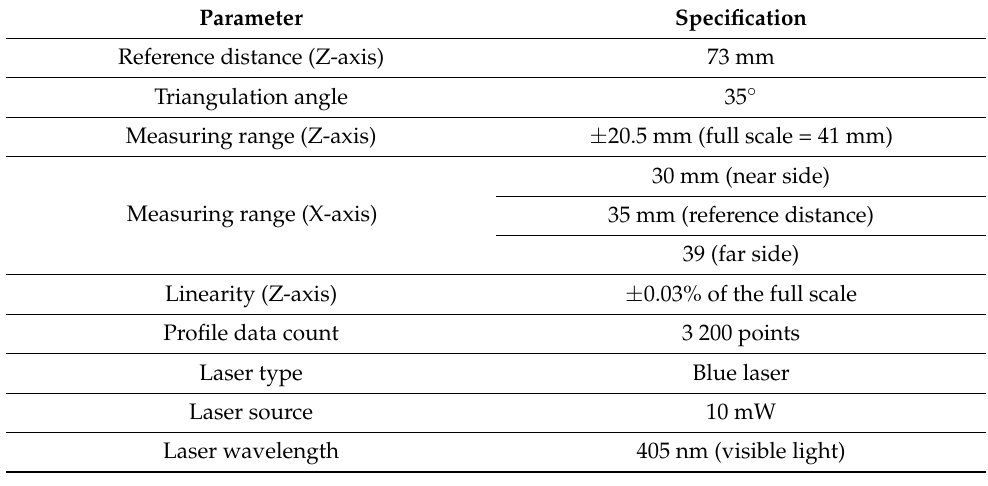
Table 2. Parameters of LJ-X8080